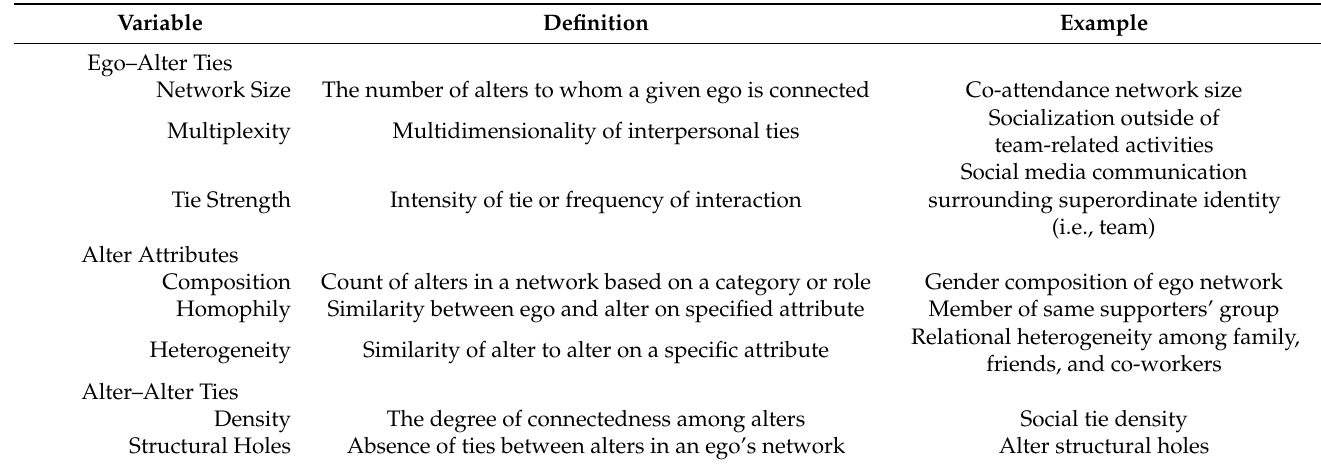
Table 1. Egocentric network variables